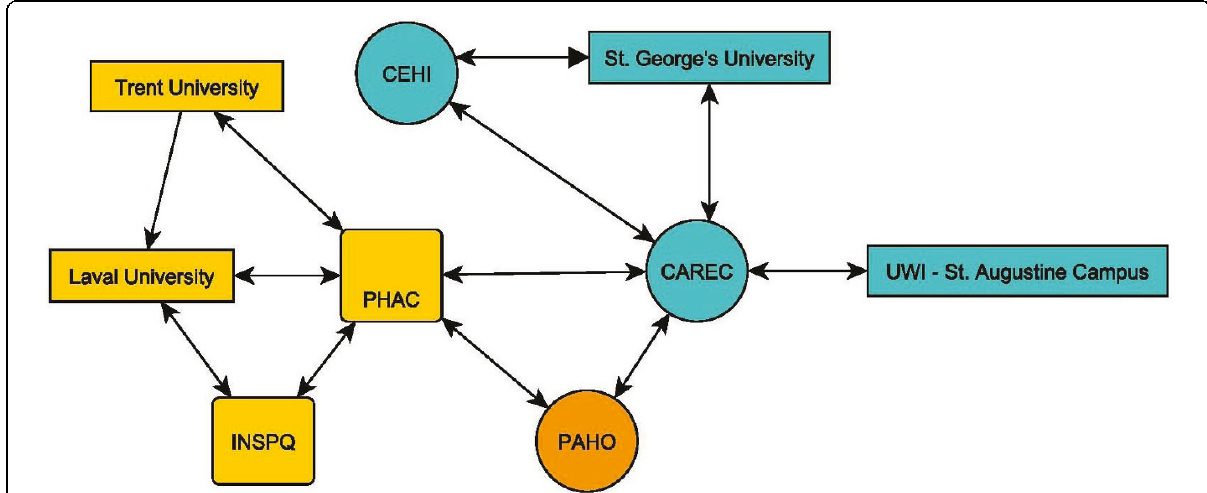
Figure 3 Schematic Diagram of Original Program Partners as of 2007. Legend: Yellow (Canadian), Blue (Caribbean) and Orange